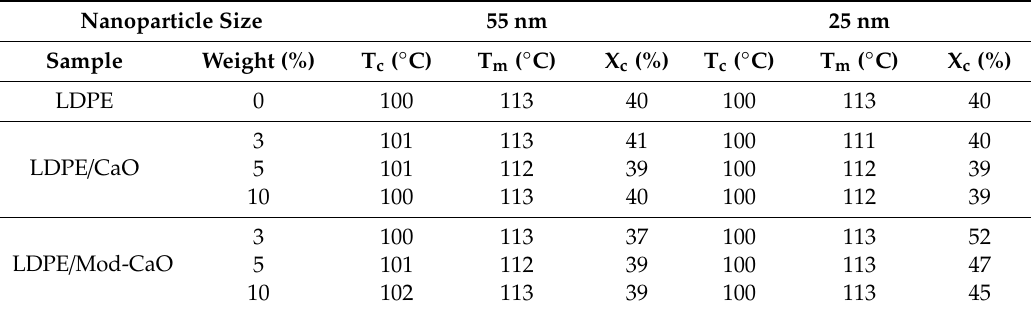
Figure 6. Differential scanning calorimetry of LDPE, LDPE/CaO, and LDPE/Mod-CaO nanocomposites with ( a ) ca. 55 nm- and ( b ) ca. 25 nm-size nanoparticles showing the melting temperature (Tm). Table 1. Crystallization temperature, melting temperature, and crystallization percentage of LDPE nanocomposites incorporating CaO of approximately 55 nm and 25 nm